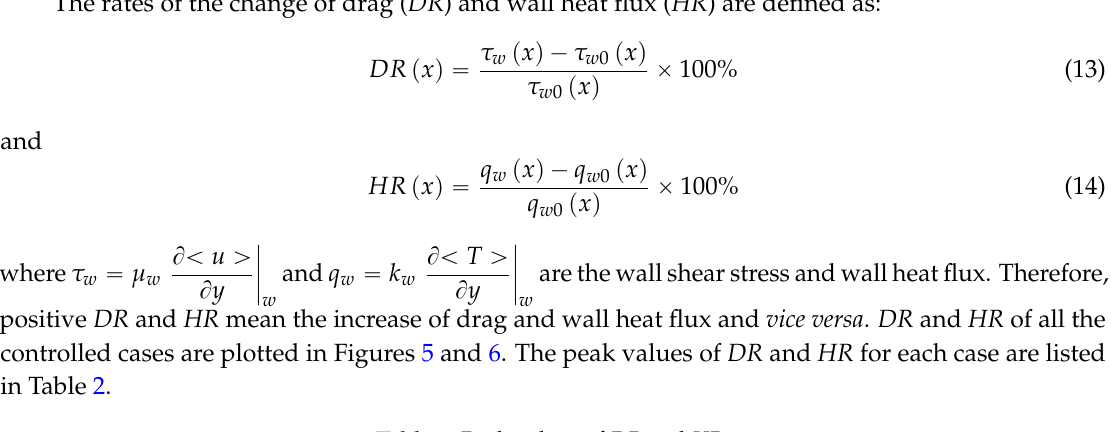
Table 2. Peak values of DR and HR